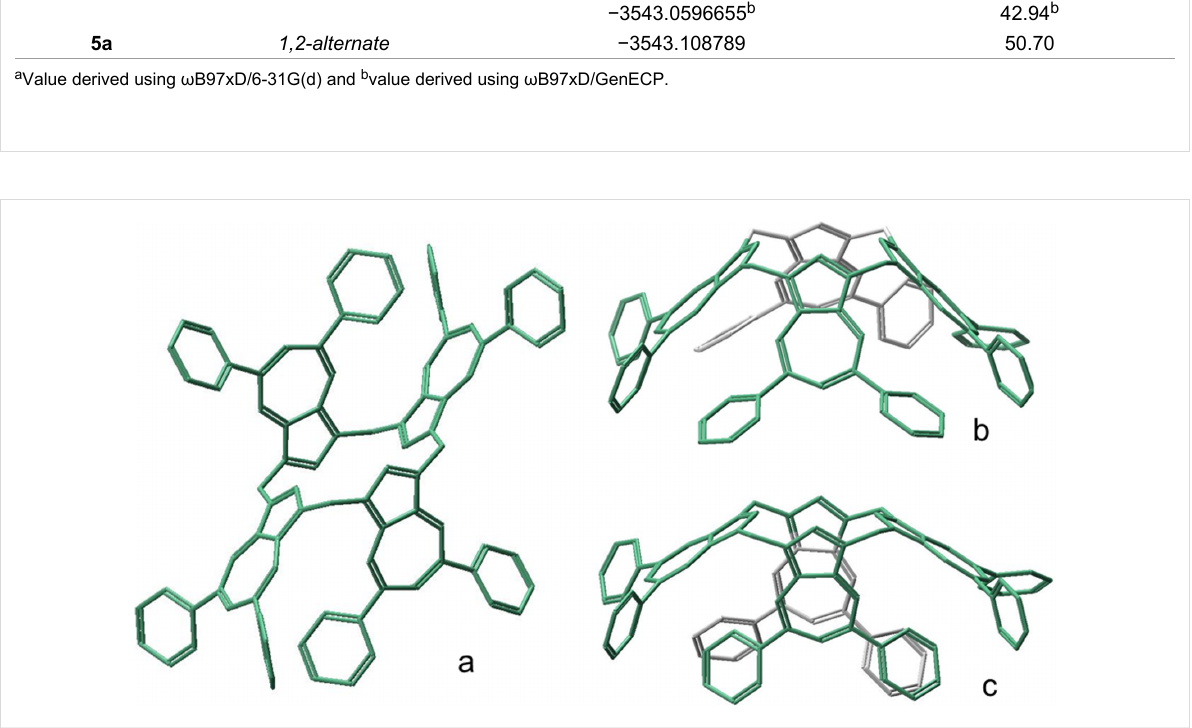
Figure 2: Three major computed conformers of OPC4A; a: 1,2-alternate ; b: cone and c: